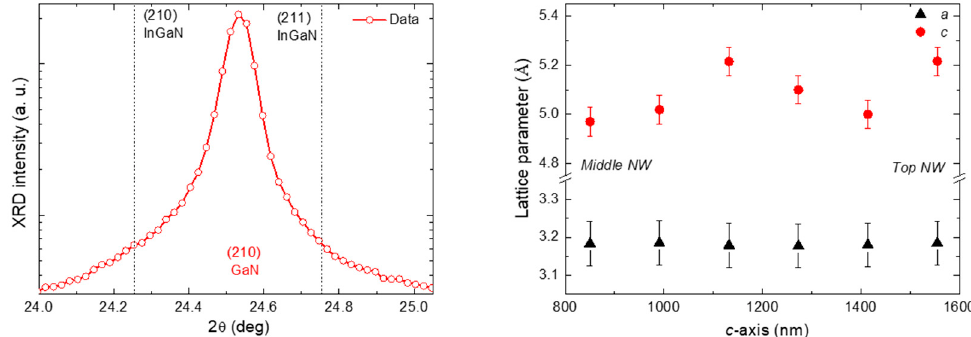
Figure 4. ( a ) XRD di ff raction peak measured in the middle region of an individual NW and plotted in log-scale. The dashed lines indicate the positions of XRD peaks corresponding to unstrained GaN (210) and InGaN (210) and (211) with an average In concentration of x = 0.076. ( b ) Evolution of the wurtzite lattice parameters a and c along the z-axis of the NW, starting from the middle of the NW towards its top.